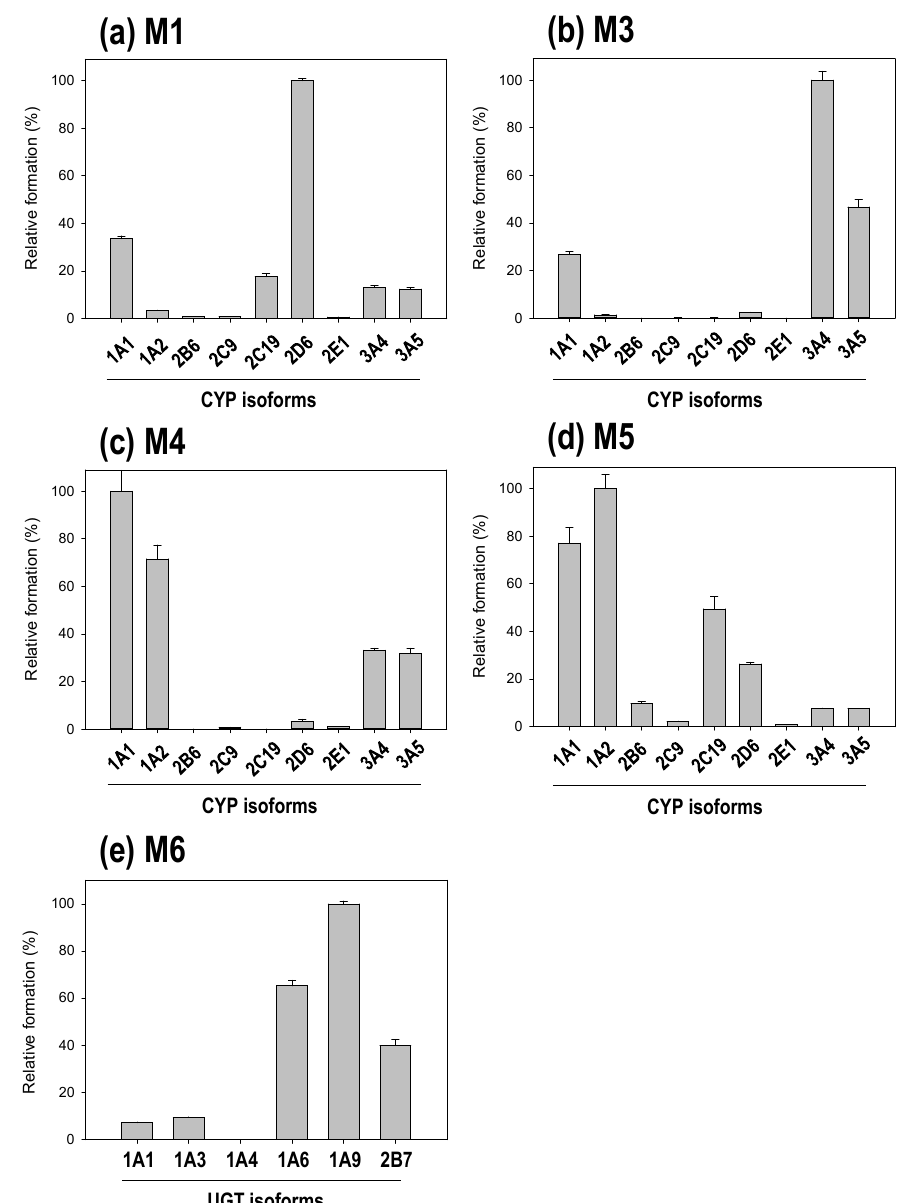
Figure 4. The formation of osthenol metabolites in human recombinant cDNA-expressed cytochrome P450 (CYP) isoforms ( a – d ) or cDNA-expressed uridine 5′-diphospho-glucuronosyltransferase (UGT) isoforms ( e ). Osthenol (20 μM) was incubated with each enzyme (5 pmole) for 60 min at 37 °C in the presence of a NADPH-regenerating system and 5 mM uridine 5′-diphosphoglucuronic acid. Data are expressed as the means ± SE of three independent determinations.